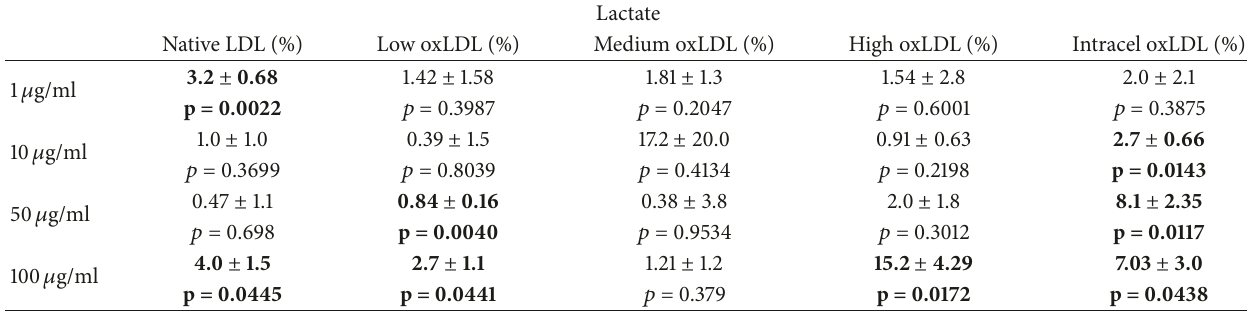
Table 2: Metabolic lactate production of various LDL exposure to macrophages. Mean peak MAMP height changes and standard errors for each experimental condition during exposure. All 𝑝 values are calculated based on peak height versus 10min average basal value prior to exposure. Terms in bold are representative of 𝑝 < 0.05 , indicating statistical significance.